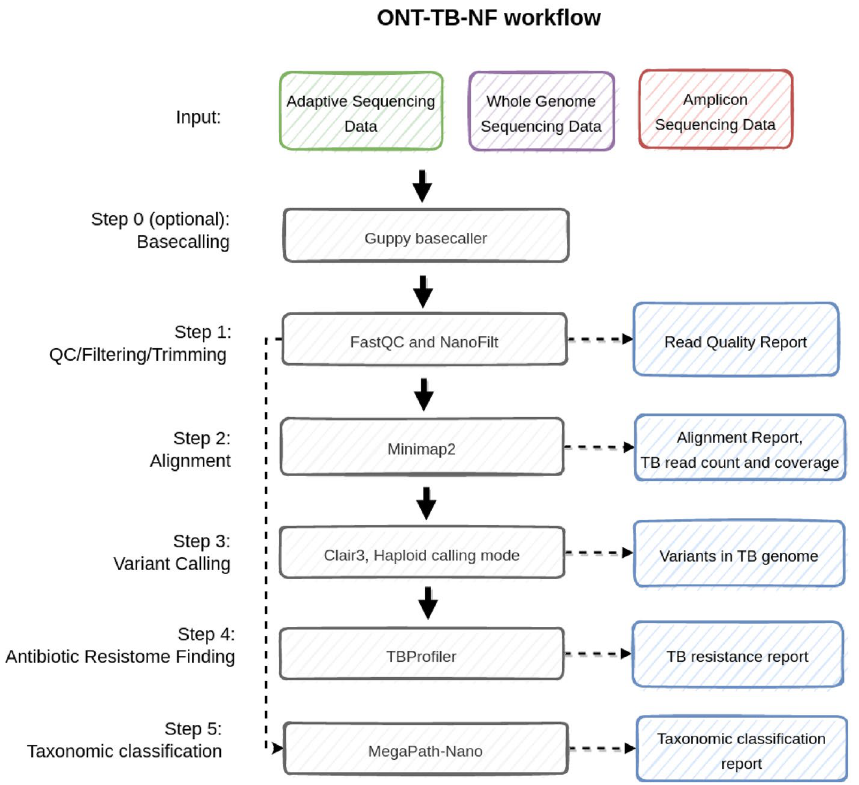
Figure 4. Workflow of the TB analysis